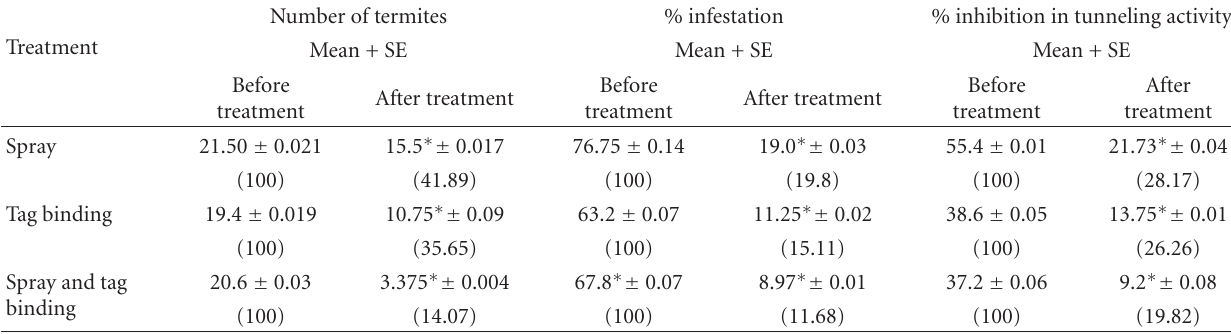
Table 3: Termite management after employment of tag binding and spray on infested garden plants.